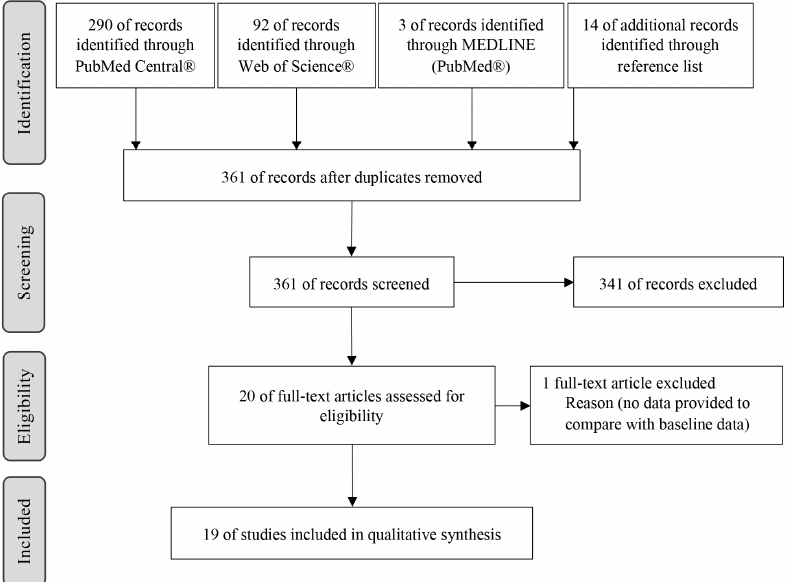
Figure 1. Search strategy and study selection.